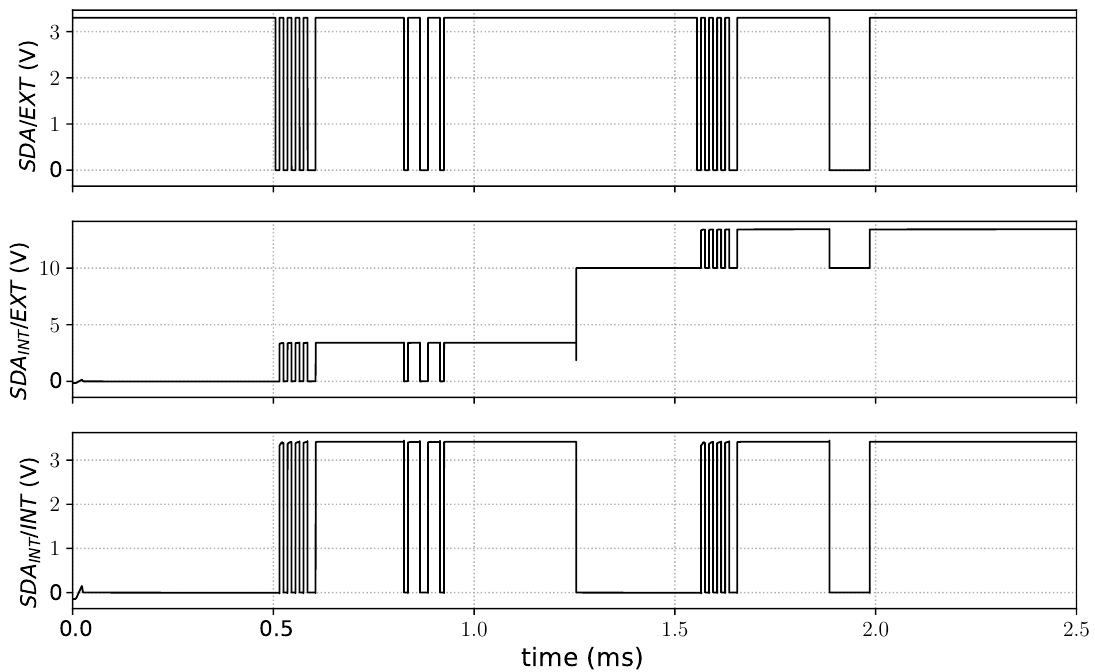
Figure 4. Simulation of DataRec using the SDA line of the inter-integrated circuit (I 2 C) protocol. At t = 1.25 ms the internal reference voltage is changed. ( top ) The external SDA signal. ( middle ) Internal SDA signal wrt. the external reference voltage. ( bottom ) The internal SDA signal vs. the internal reference